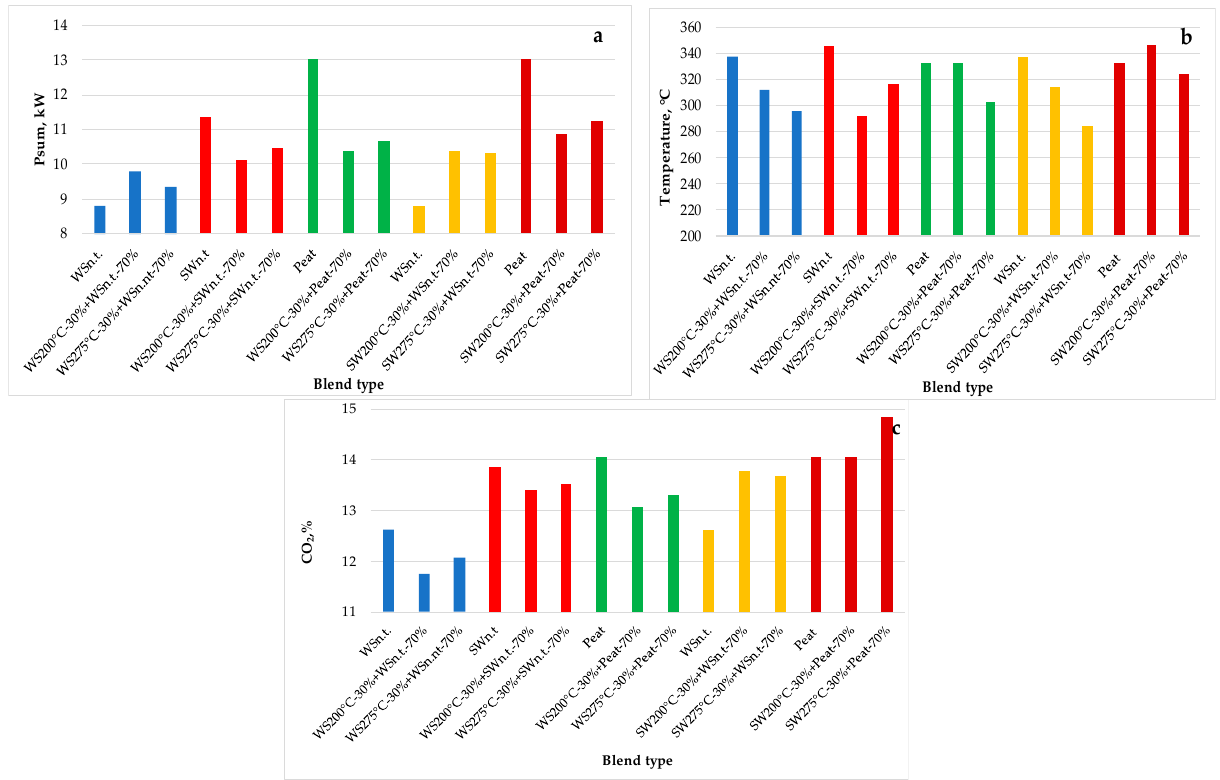
Figure 4. Tests of the influence of composition and temperature of MW pre-treated wheat straw and softwood binary blends with raw biomass pellets on the heat power of the device ( a ), temperature at the outlet of the furnace ( b ) and the volume fraction of CO 2 in the products ( c ). Binary blends consisting of non-treated and pre-treated wheat straw, non-treated softwood and pre-treated wheat straw, non-treated peat and pre-treated wheat straw, non-treated wheat straw and pre-treated soft- wood, non-treated peat and pre-treated softwood are in blue, rich red, green, yellow, red-brown colors correspondingly.